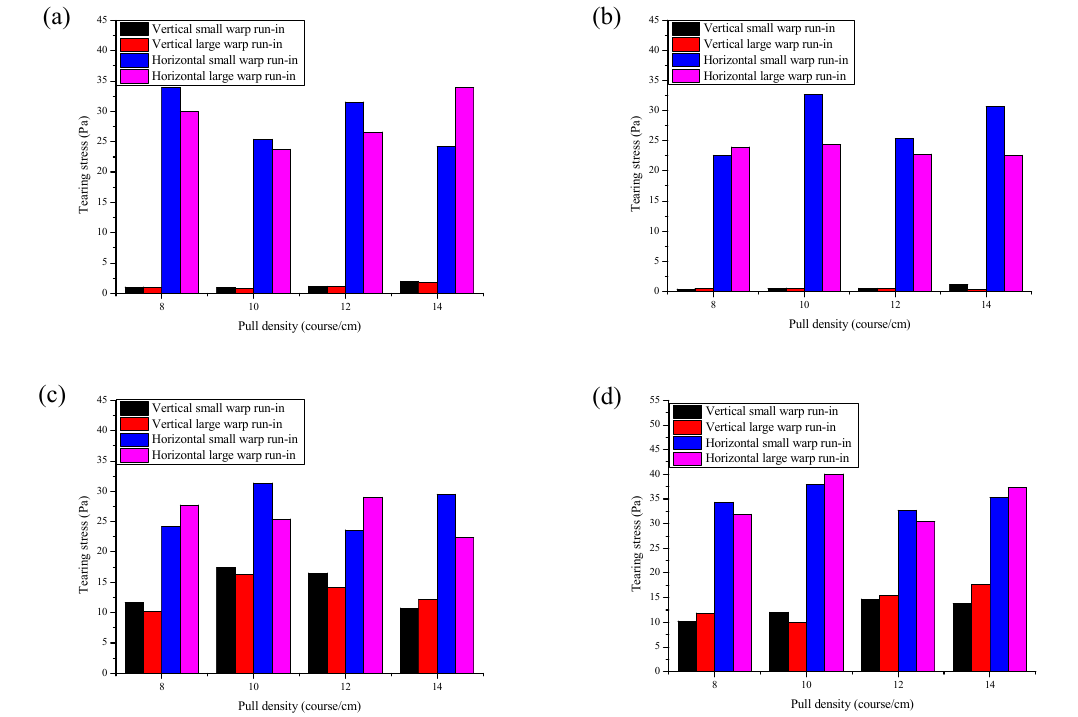
Figure 6. The relationship between the pull density and the vertical and horizontal tearing stress: ( a ) fabric 1#; ( b ) fabric 2#; ( c ) fabric 3#; and ( d ) fabric 4#.